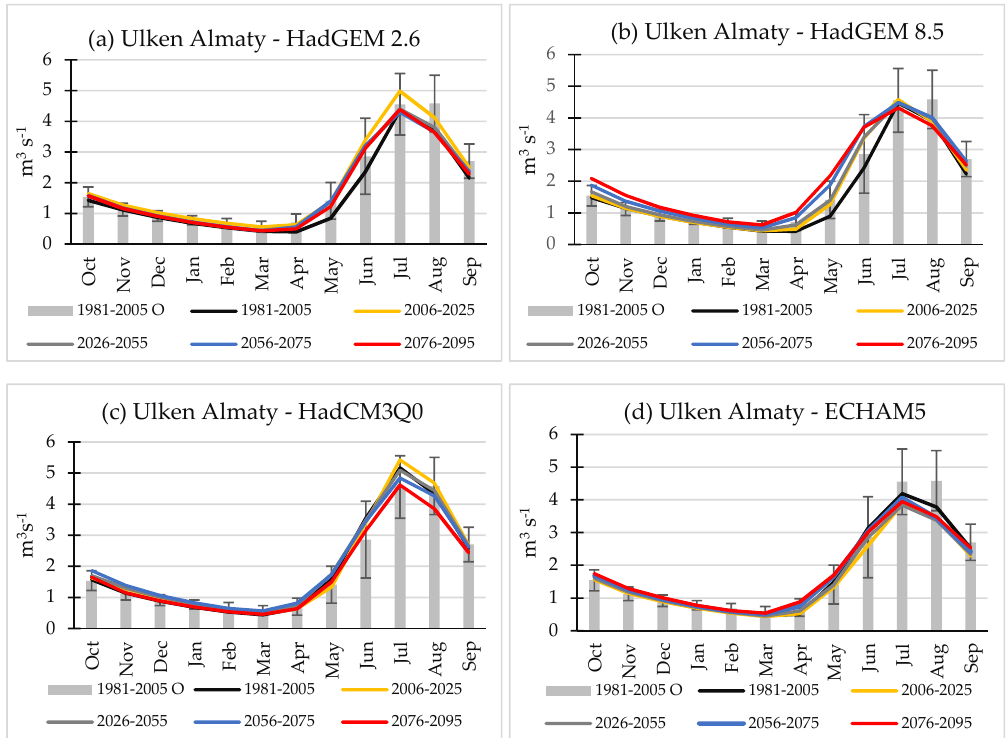
Figure 12. Streamflow scenarios for the Ulken Almaty based on the PRECIS outputs for the baseline period (1981–2005; glacierization for 1990 and 2006) and future 25-year time slices. Grey bars show observed flow values and their standard deviations (±1 σ shown by vertical bars).